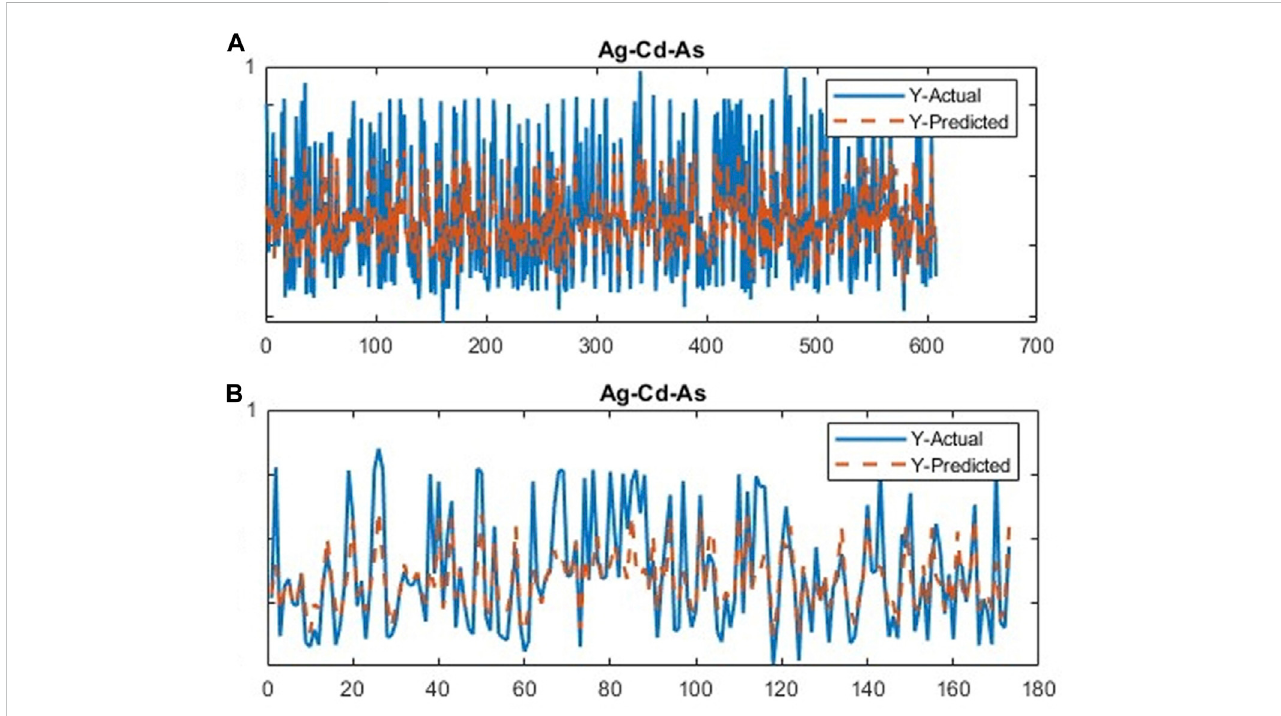
FIGURE 7 Plot of the running CDL network for the second stage of clustering the second group of geochemical indicator elements (Ag – Cd – As); (A) training data and (B) testing data.